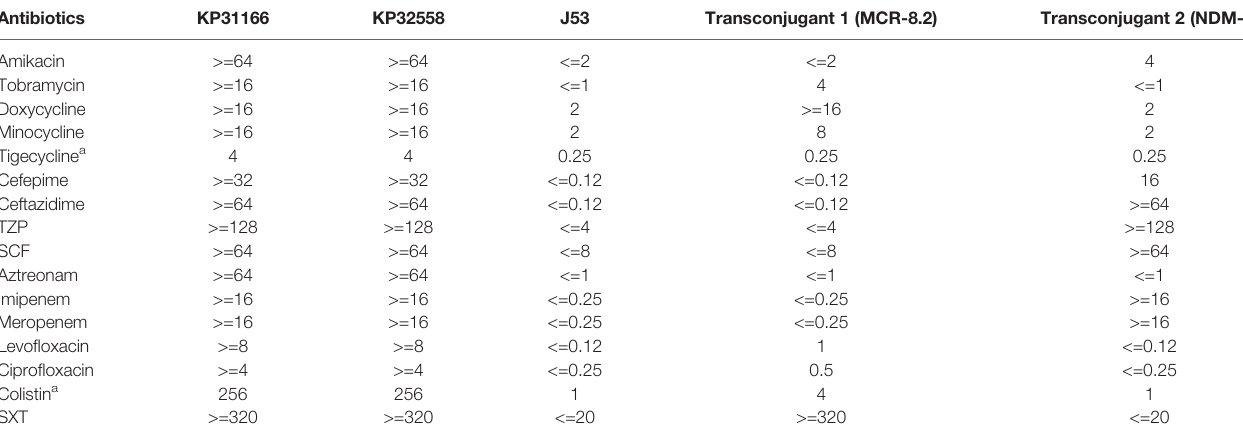
TABLE 1 | Antibiotic resistance characteristics (MICs, mg/L) of 4 clinical K. pneumoniae strains and the transconjugant of KP32558.